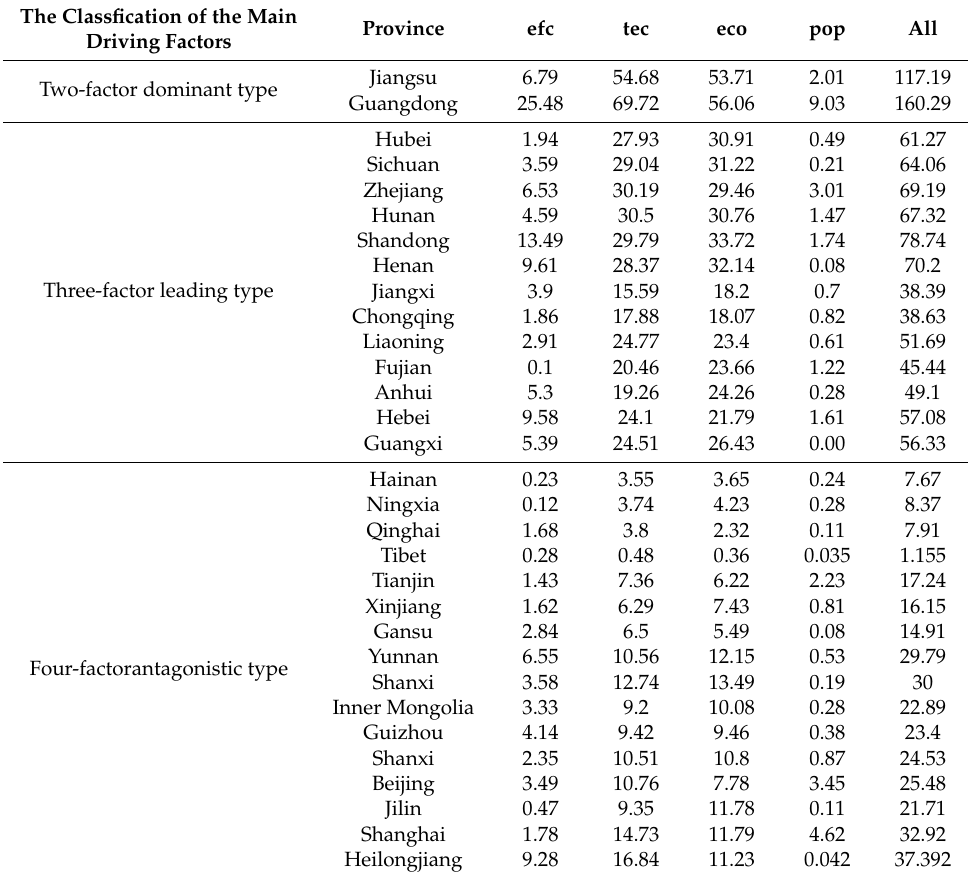
Table 2. The classification of the main driving factors affecting the provincial wastewater discharge in China (per one hundred million cubic